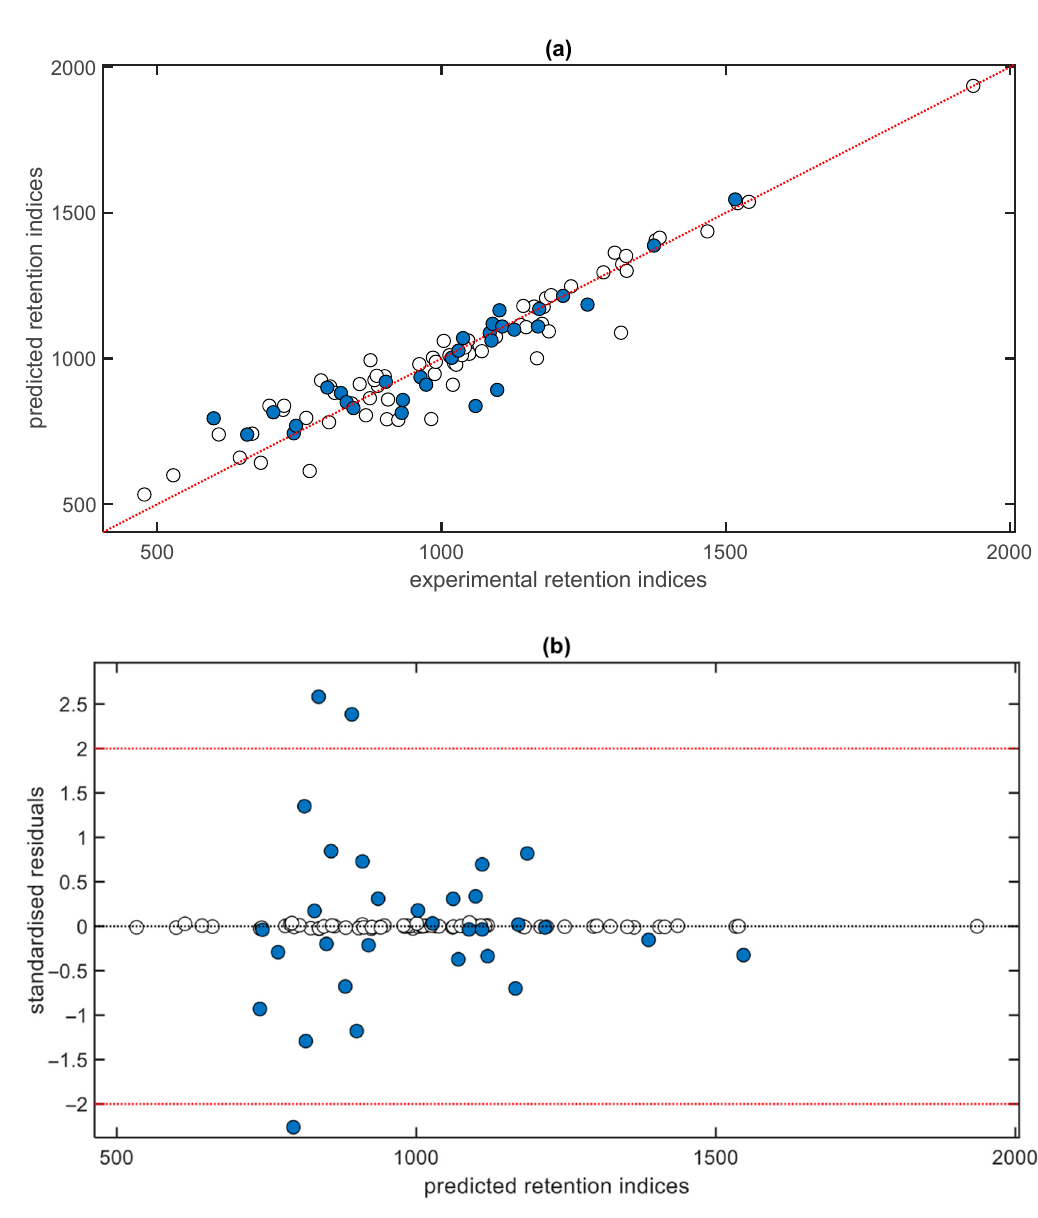
Figure 1. ( a ) Experimental versus predicted retention indices for the volatile and semi-volatile organic compounds of coffee detected in the DVB/CAR/PDMS fiber in the HS-SPME-GC-TOFMS technique. ( b ) Standardized residuals versus the predicted retention indices for the VOCs and SVOCs identified in coffee samples. Training set molecules are labeled in black, and test set compounds are labeled in blue.